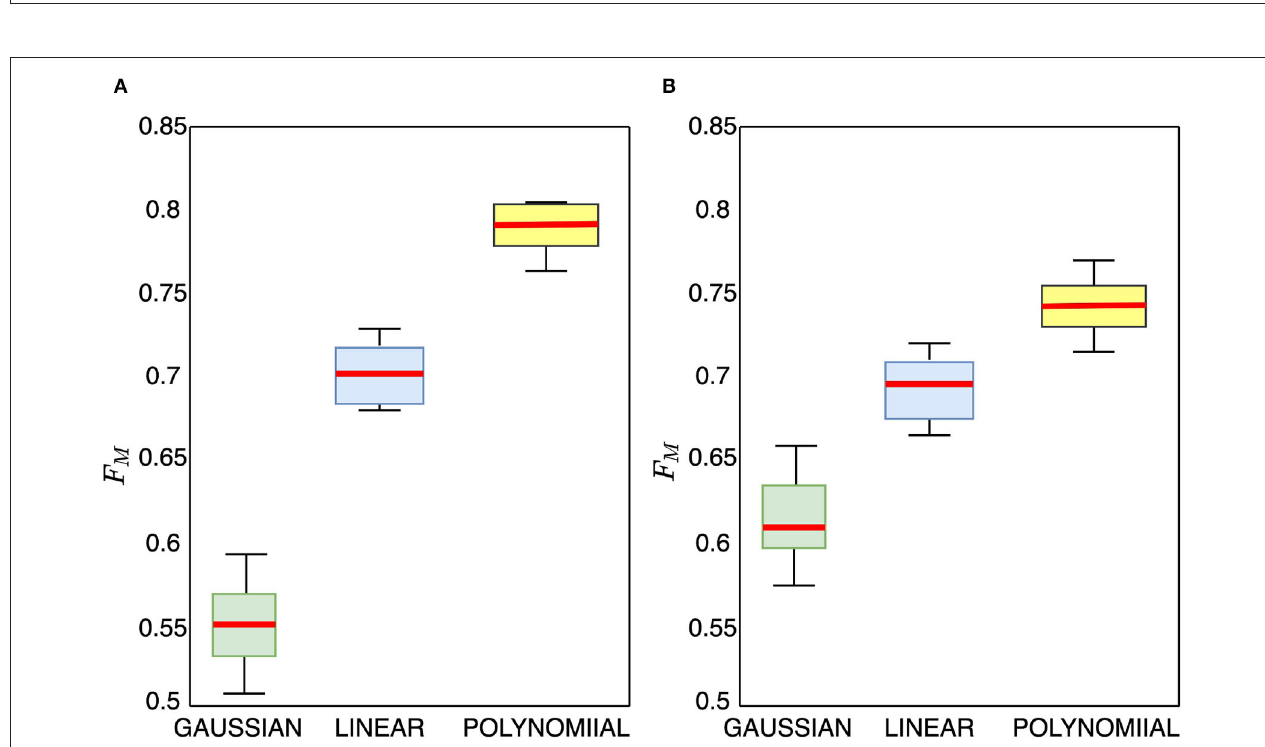
FIGURE 6 | Box plots ablation experiment for valence cross-subject classification accuracy on MAHNOB-HCI and DEAP data using Gaussian, linear, and polynomial kernel mapping functions, (A) MAHNOB-HCI, (B) DEAP.